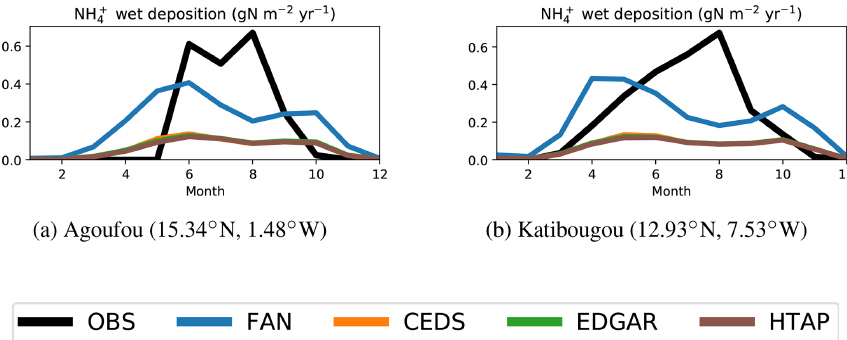
Figure 11. Simulated and observed wet deposition of ammonium (µgNm − 3 yr − 1 ) in Agoufou and Katibougou. The simulated wet deposi- tion includes both scavenged aerosol-phase ammonium and the dissolved gaseous